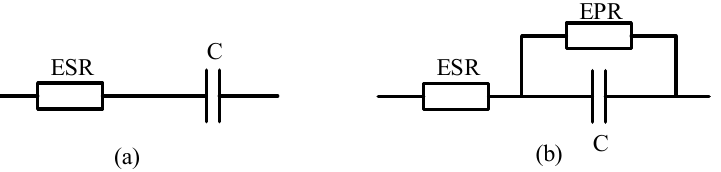
Figure 5. Simple series RC model: ( a ) simple series RC model; ( b ) the simple model of series-parallel connection.